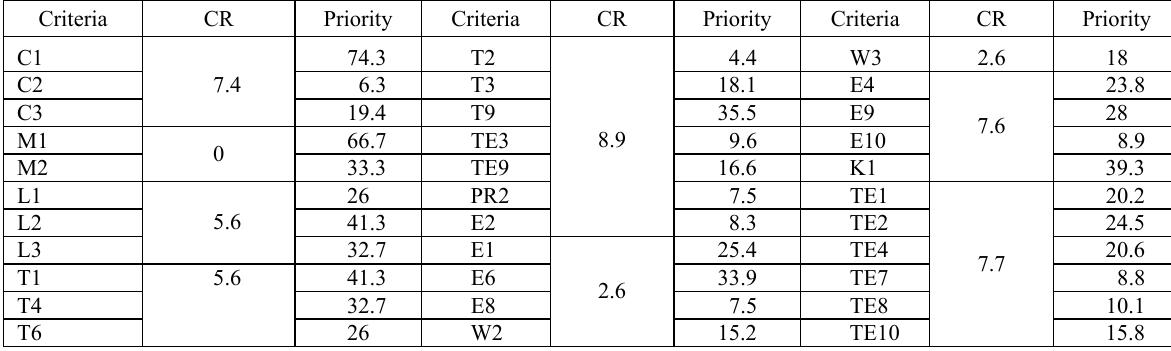
Table 5. Sub-criteria, local performance scores